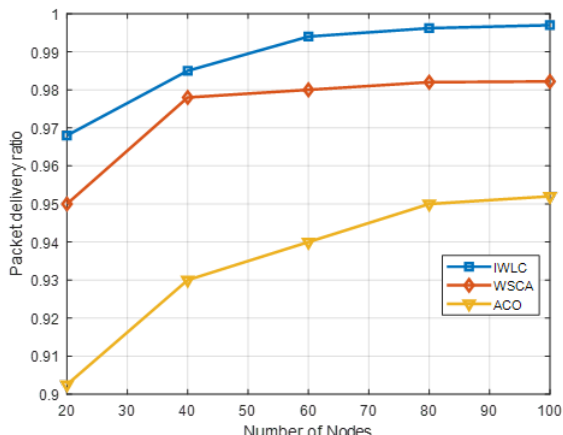
Figure 9. PDR in different clustering schemes with varying numbers of UAV nodes.